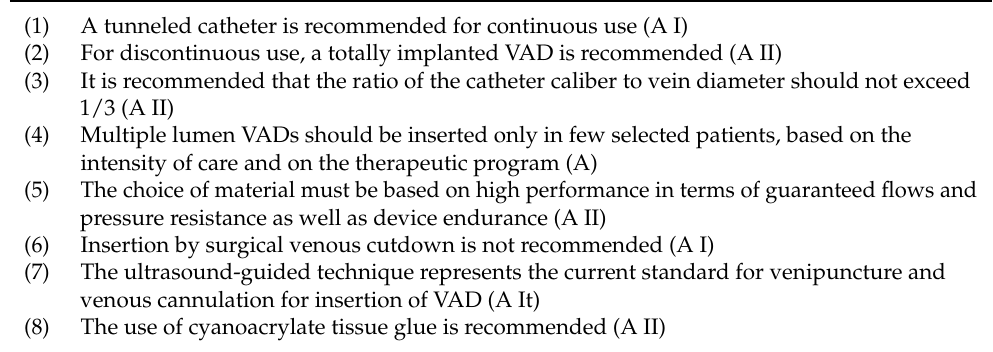
Table 1. AIEOP Recommendations for VADs Positioning